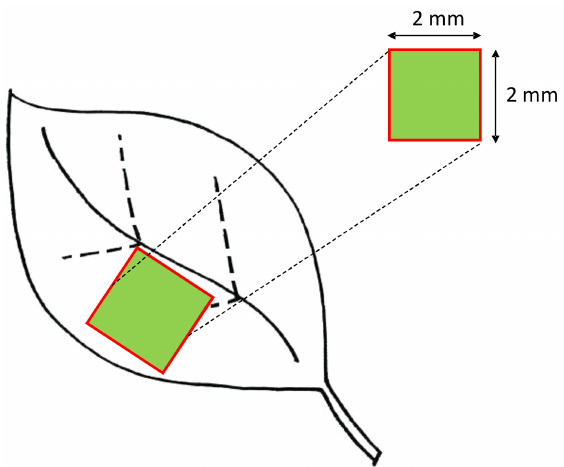
Figure 2. Investigated area on Thai basil leaf samples using high-accuracy digital